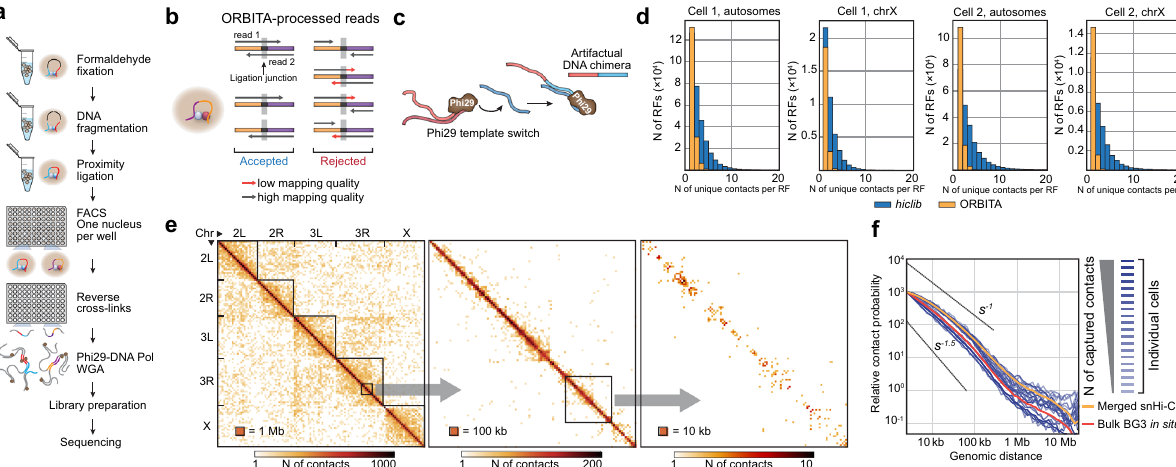
Fig. 1 ORBITA-processed Hi-C data from single Drosophila nuclei. a Single-nucleus Hi-C protocol scheme (see “ Methods ” for details). b Work fl ow of ORBITA function for detection of unique Hi-C contacts. ORBITA processes only chimeric reads with good mapping quality containing ligation junction marked by the cleavage site for restriction enzyme used for the snHi-C map construction. c Scheme of an artefactual DNA chimera formation by Phi29- DNA-polymerase. d Number of unique contacts per restriction fragment (RF) captured by ORBITA (orange) and hiclib (blue) for autosomes and the X chromosome. BG3 is a diploid male cell line; accordingly, in a single nucleus, each RF from autosomes and the X chromosome could establish no more than four and two unique contacts, respectively. Cell 1, autosomes: n = 148,415 and 159,060 for ORBITA and hiclib , respectively; ChrX: n = 22,016 and 26,674 for ORBITA and hiclib , respectively. Cell 2: autosomes: n = 113,988 and 119,066 for ORBITA and hiclib , respectively; ChrX: n = 16,384 and 19,429 for ORBITA and hiclib , respectively. e Visualization of a single-nucleus Hi-C map at 1-Mb, 100-kb, and 10-kb resolution for the cell with 107,823 captured unique contacts. f Dependence of the contact probability P c ( s ) on the genomic distance s for single nuclei (shades of blue re fl ect the number of unique contacts captured in individual nuclei), merged snHi-C data (orange), and bulk in situ BG3 Hi-C data (red). Black lines show slopes for P c ( s ) = s − 1.5 and P c ( s ) = s − 1 .